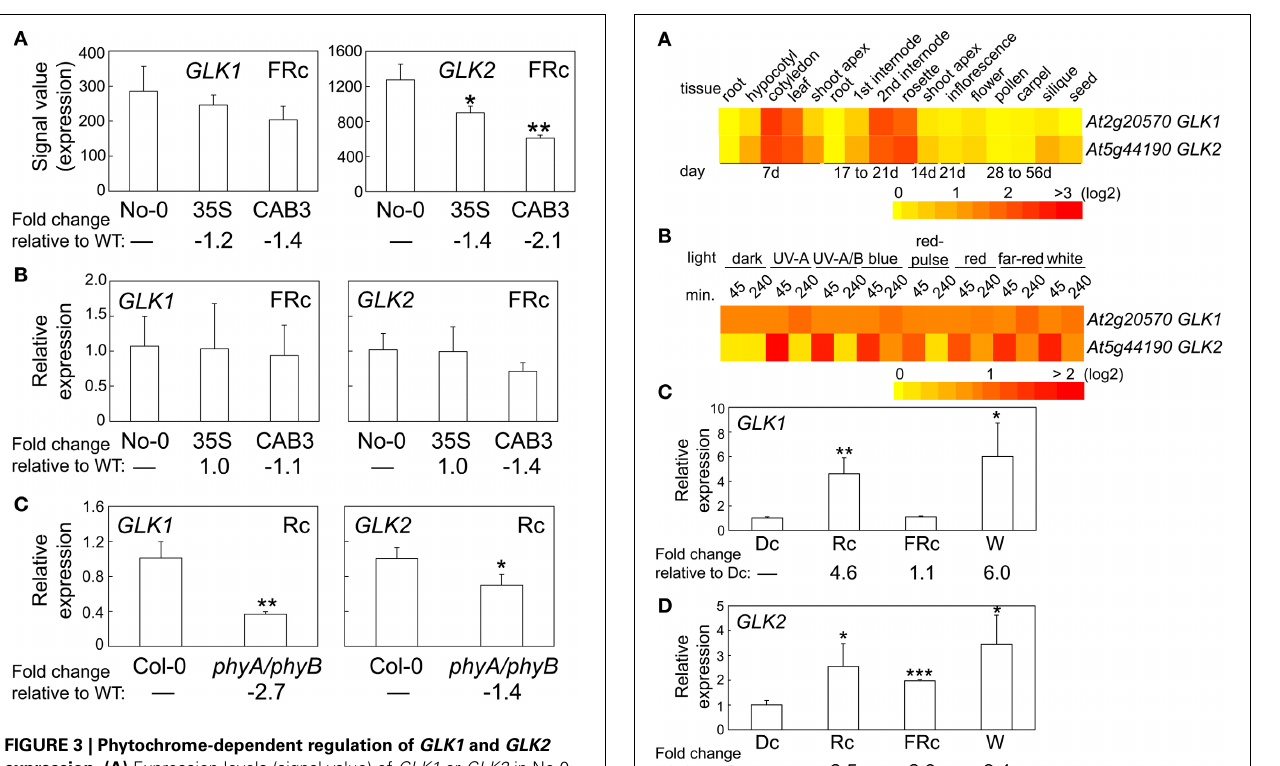
FIGURE 3 | Phytochrome-dependent regulation of GLK1 and GLK2 expression. (A) Expression levels (signal value) of GLK1 or GLK2 in No-0 WT, 35S, and CAB3 under FRc are shown ( ± SD , n = 3). (B) qRT-PCR validation of microarray data for GLK1 or GLK2 under FRc. Relative GLK1 or GLK2 expression level compared to UBC21 is shown ( ± SD , n = 3). (C) qRT-PCR quantification of GLK1 or GLK2 expression in Col-0 WT or phyA/phyB double mutant seedlings under Rc. Relative GLK1 or GLK2 expression level compared to UBC21 is shown ( ± SD , n = 3). Statistics: